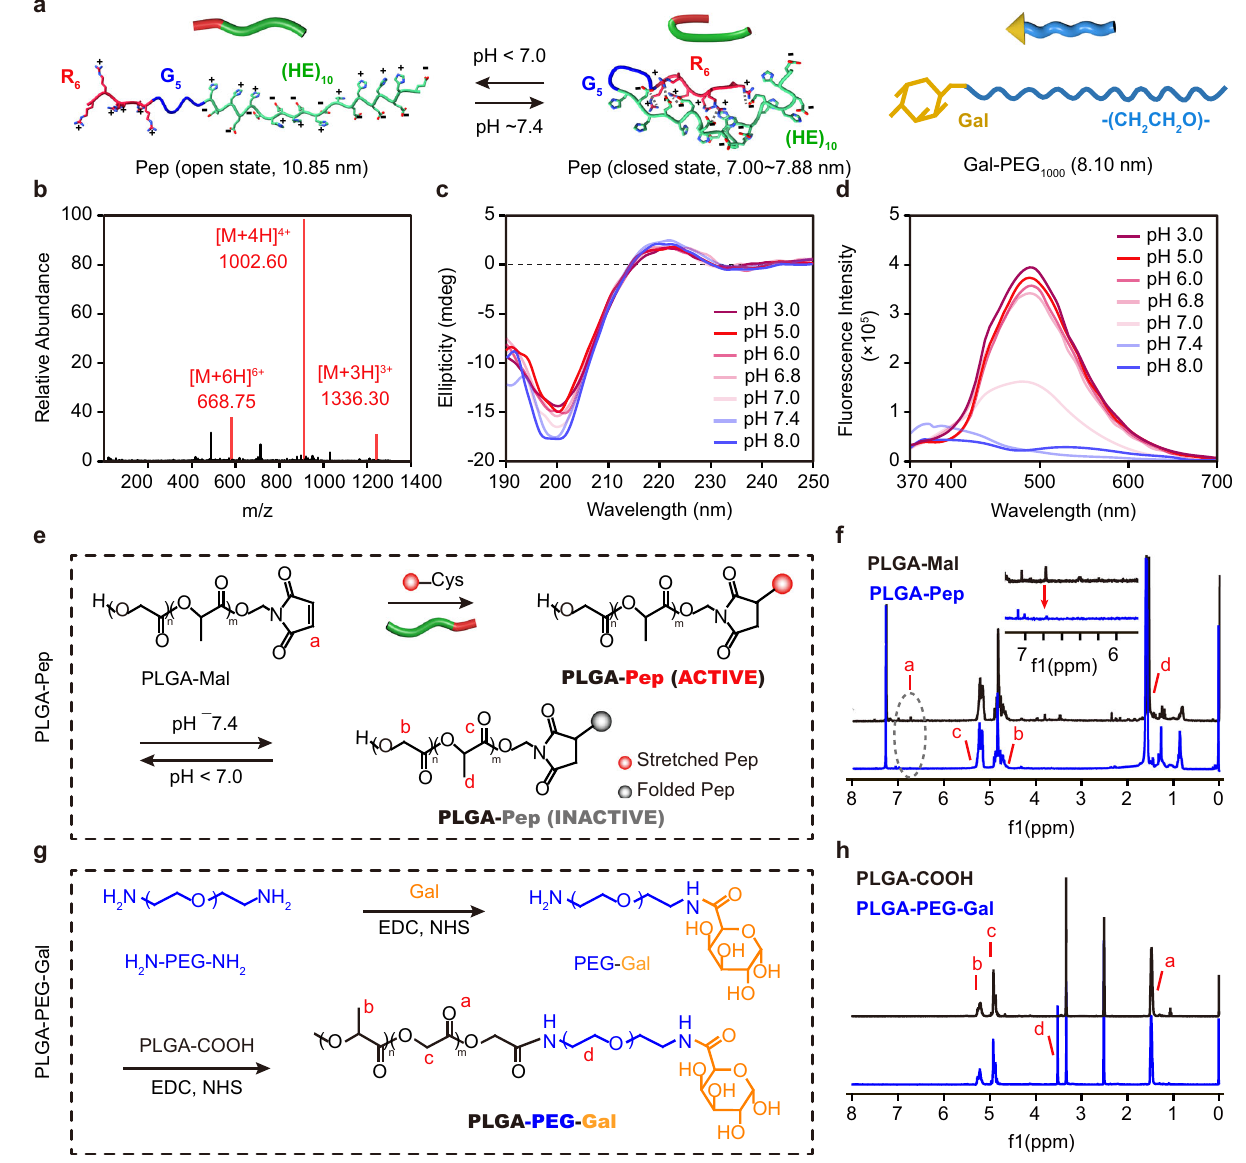
Fig. 2 | Synthesis and characterization of functional polymers. a Schematic illustration of pH-responsive stretchable cell-penetrating peptide (Pep) and polyethylene glycol-galactose (PEG-Gal) polymers and their theoretical lengths. Open- and closed-state models of Pep under different pH conditions. H: histi- dine; E: glutamic acid; G: glycine; R: arginine. b Mass spectrum of Pep. c Circular dichroism spectra of Pep under different pH conditions. d Emission spectra of